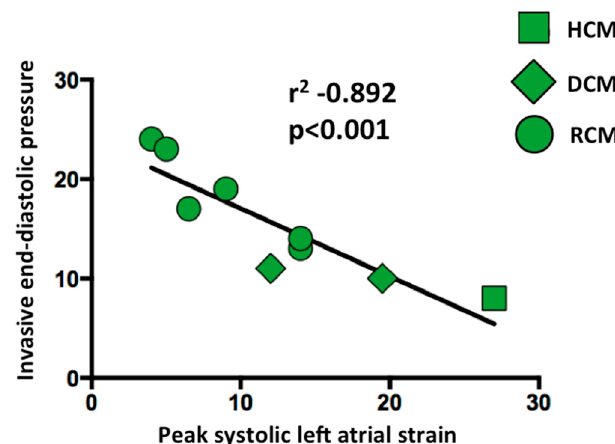
Figure 6. Linear correlation between left ventricular end-diastolic pressures and left atrial peak systolic strain. The graph shows a strong significant inverse correlation between peak systolic LA strains and invasive LV end-diastolic pressures (r − 0.892, p < 0.001). HCM: Hypertrophic DCM: Dilated Cardiomyopathy. RCM: Restrictive